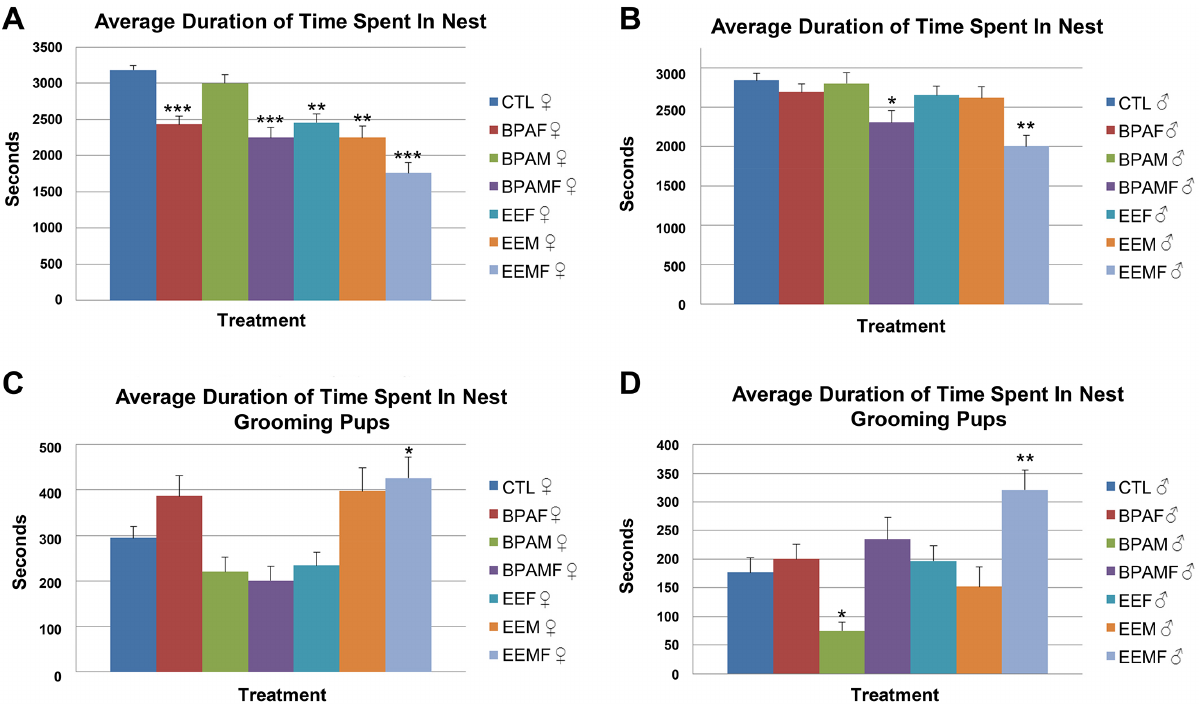
Fig 3. Average hourly duration of time from the day of birth to the end of post-natal day 5 that parents spent in the nest and grooming their pups. A, Time spent in nest by female parent; B, Time spent in nest by male parent; C, Time spent grooming the pups by female parent; D, Time spent grooming the pups by male parent. Treatment groups that differ from control pairs: * , P < 0.05, ** , P < 0.01, and *** , P <